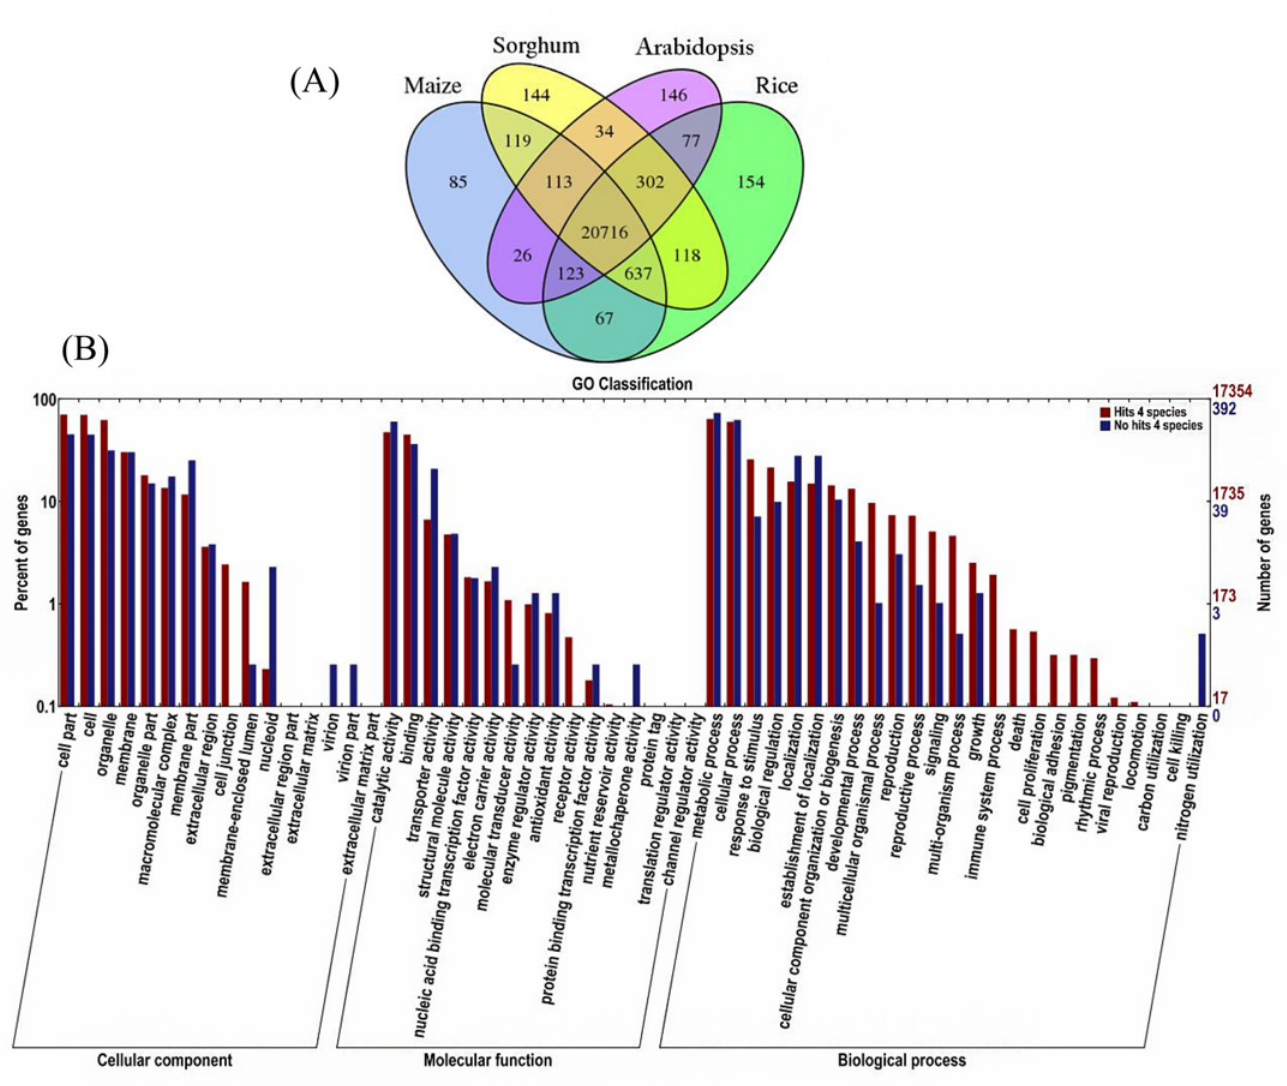
Fig 6. A . comosus var. bracteatus unigene similarity comparison with rice, maize, sorghum and Arabidopsis and functional classification by GO analysis. (A) Similarity search of A . comosus var. bracteatus sequence against rice, maize, sorghum and Arabidopsis . (B) Functional classification of A . comosus var. bracteatus unigenes with and without homologs with rice, maize, sorghum and Arabidopsis